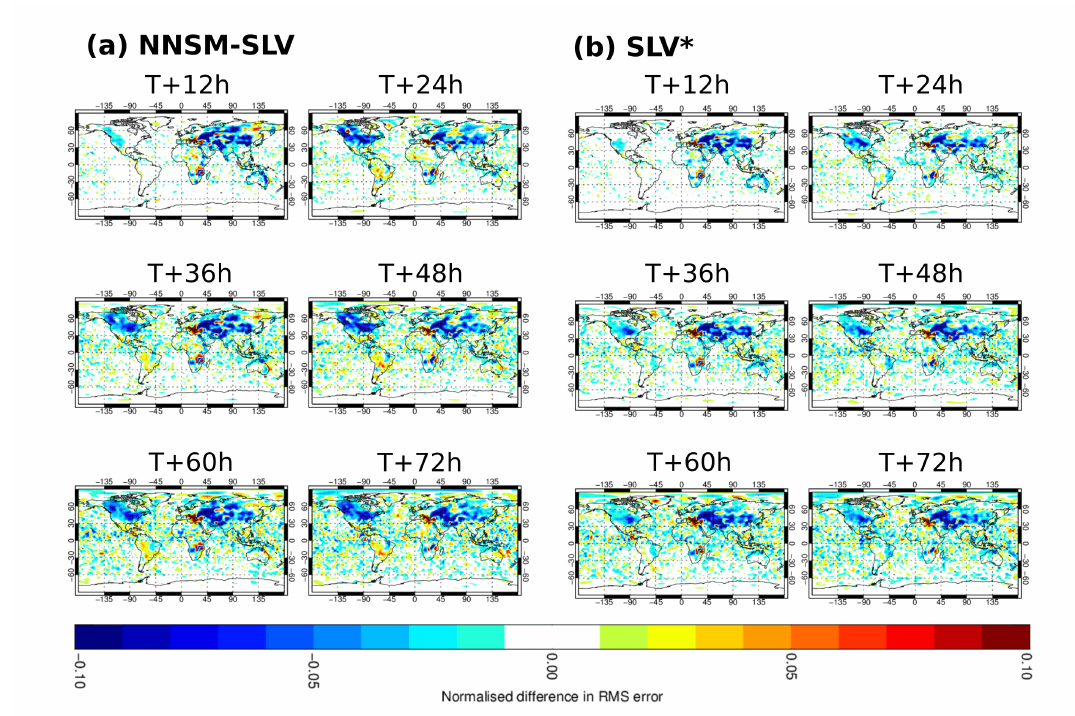
Figure 11. Evaluation on the forecast skill for air temperature at 850 hPa as a function of time (from 12 to 72 h). Average over July–September of the RMS difference of NNSM-SLV ( a ) and SLV ( b ) with respect to the open loop (negative values, blue colors, indicate an improvement of the forecast